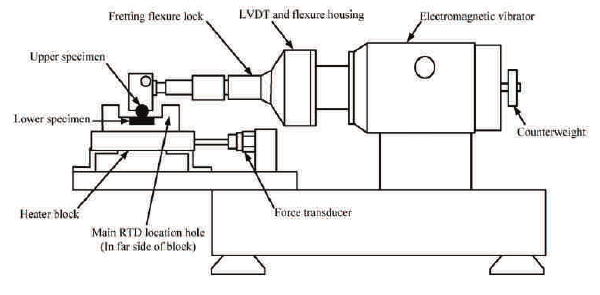
Fig. 2. Schematic diagram of the HFRR [10, 11]